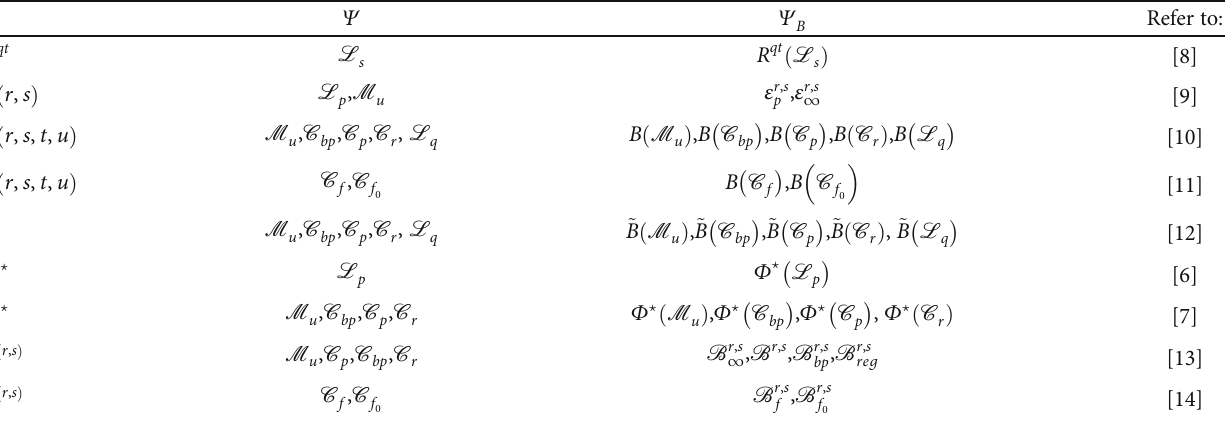
Table 1: Some 4D triangle matrices and their